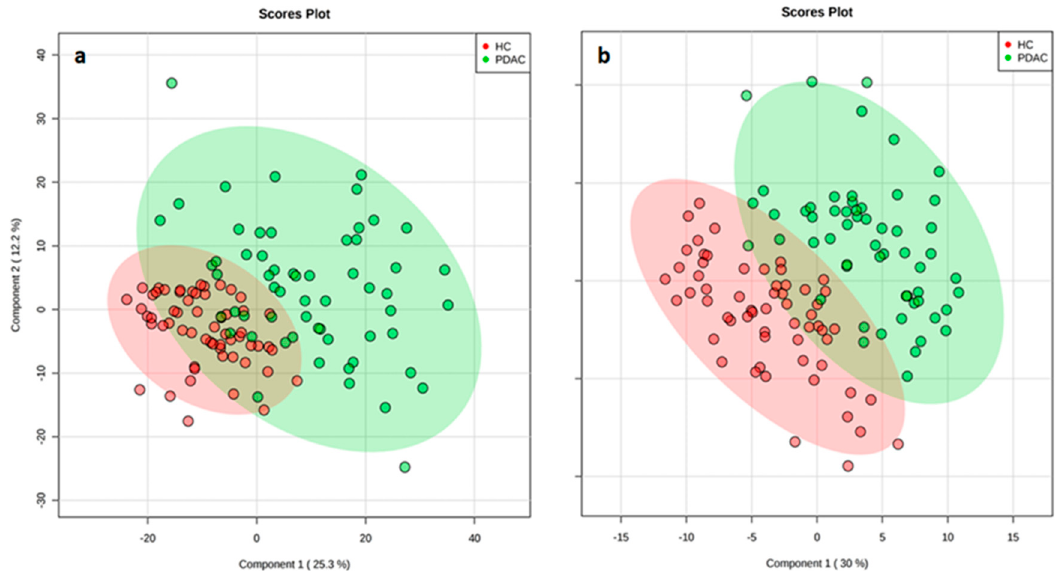
Figure 2. Partial least squares-discriminant analysis score plot shows a clear separation between the study groups (pancreatic ductal adenocarcinoma (PDAC) in green and healthy controls (HC) in red) in ESI + ( a ) and ESI- ( b ) modes, suggesting that it is possible to discriminate between PDAC patients and HC.